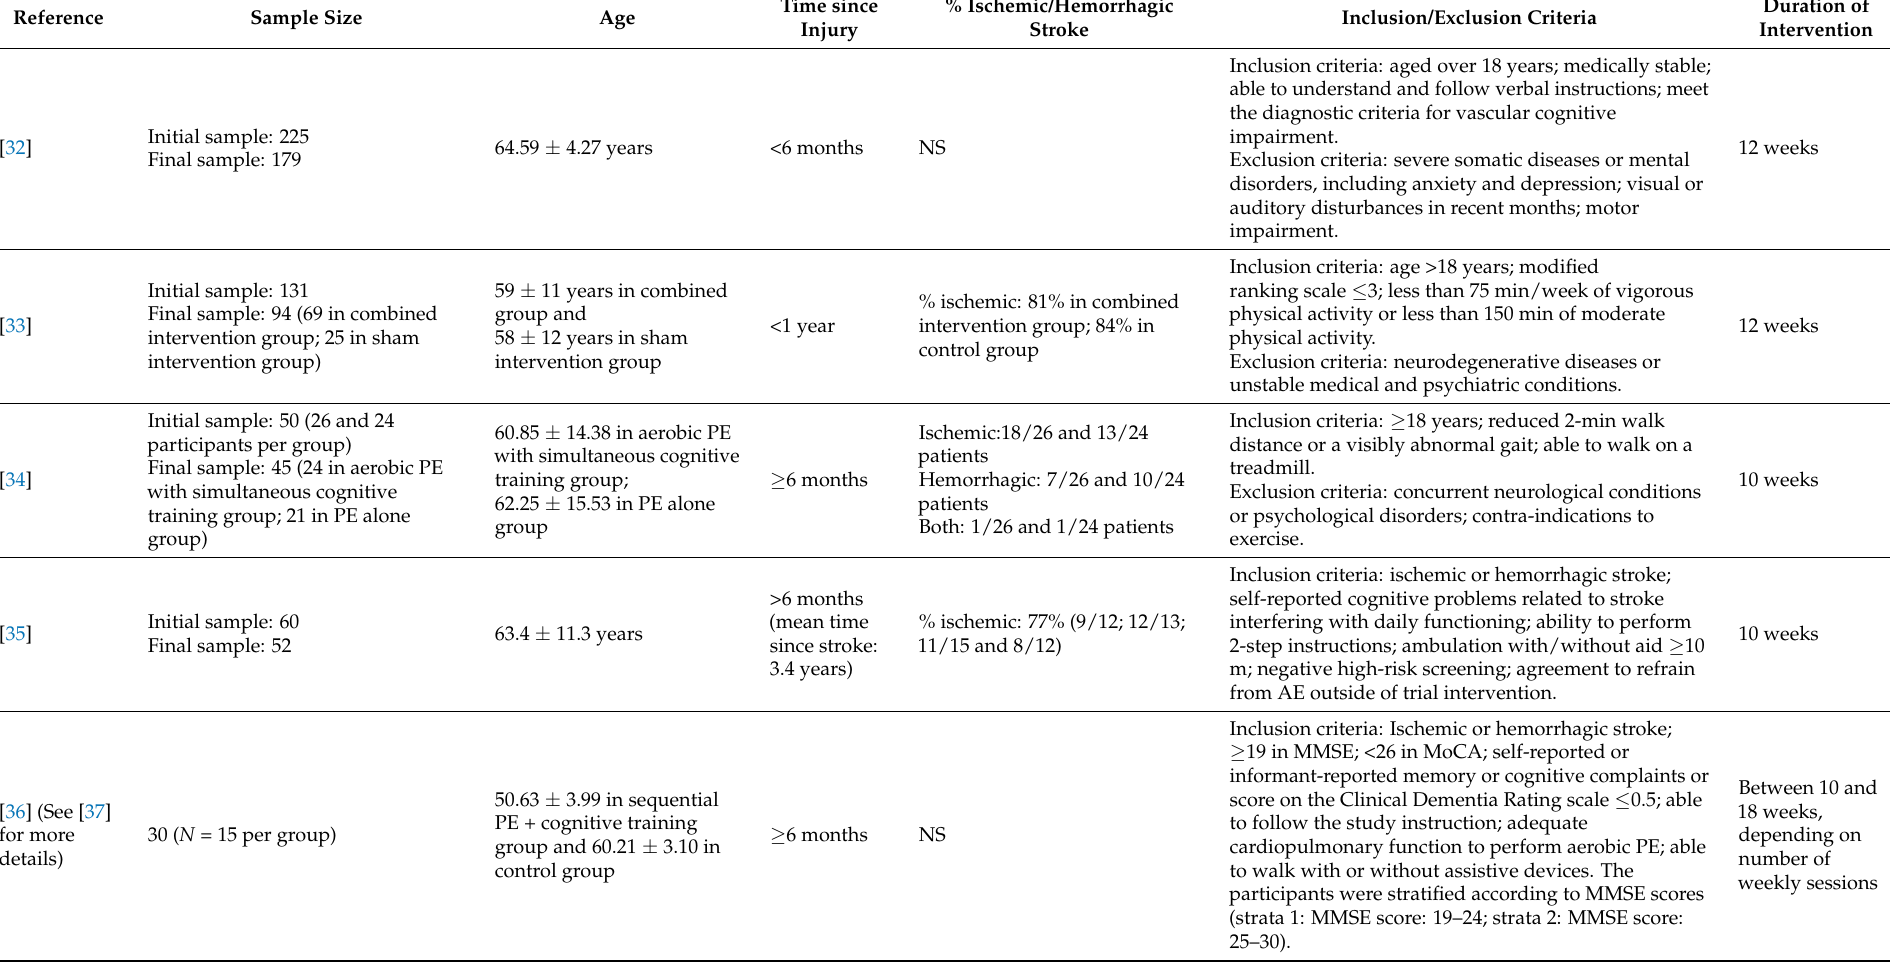
Table 1. Patients’ characteristics, inclusion/exclusion criteria, and duration of the interventions of the studies included in the systematic